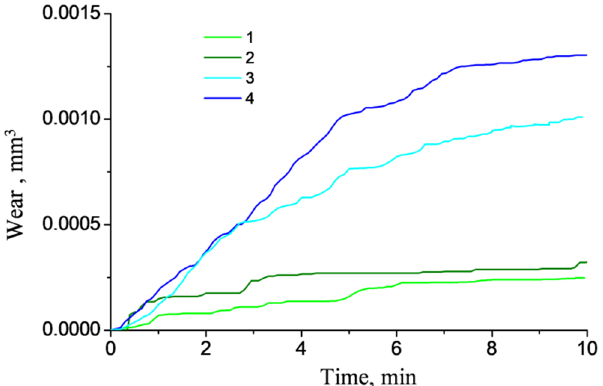
Figure 19. Wear rates of the PI/10CCF/10PTFE composite without pores (1, 3) and with them (2, 4) for different counterpart roughness: 0.1 μ m (1, 2) and 1 μ m (3, 4).